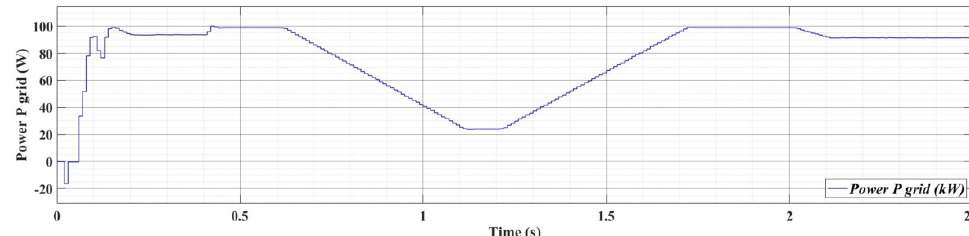
Figure 32. The time evolution of the power flow P between the PV and the main grid (signal evo- lution of the type 1 PV array).